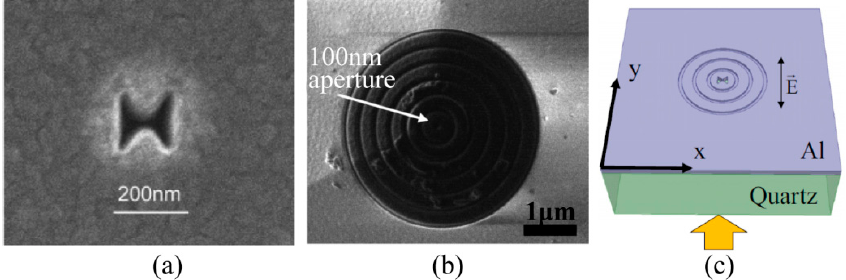
Figure 12. Various nanostructures used to confine SPPs and achieve a nano-scale spot. ( a ) Zoom in SEM picture of the bowtie aperture; ( b ) 100 nm aperture on the NSOM tip after the fabrication of the plasmonic lens; ( c ) Modified bowtie aperture with full circular grooves on the exit side of the film. Reproduced from: (a), [28], Copyright © 2006, ACS; (b), [67], Copyright © 2008, ACS; (c), [68], Copyright © 2011, AIP.